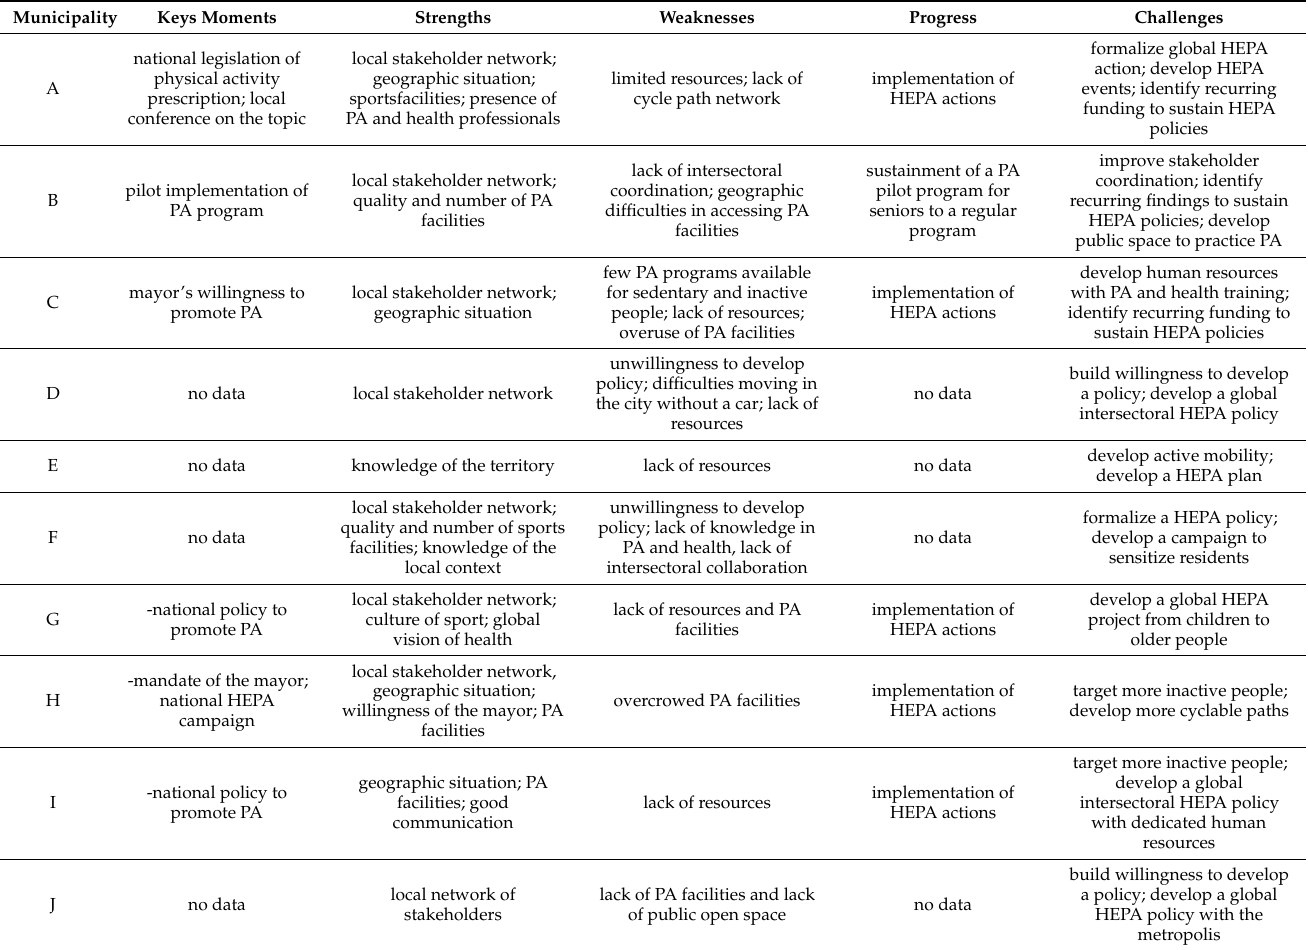
Table 4. Synthesis of Section 6: progress achieved and future